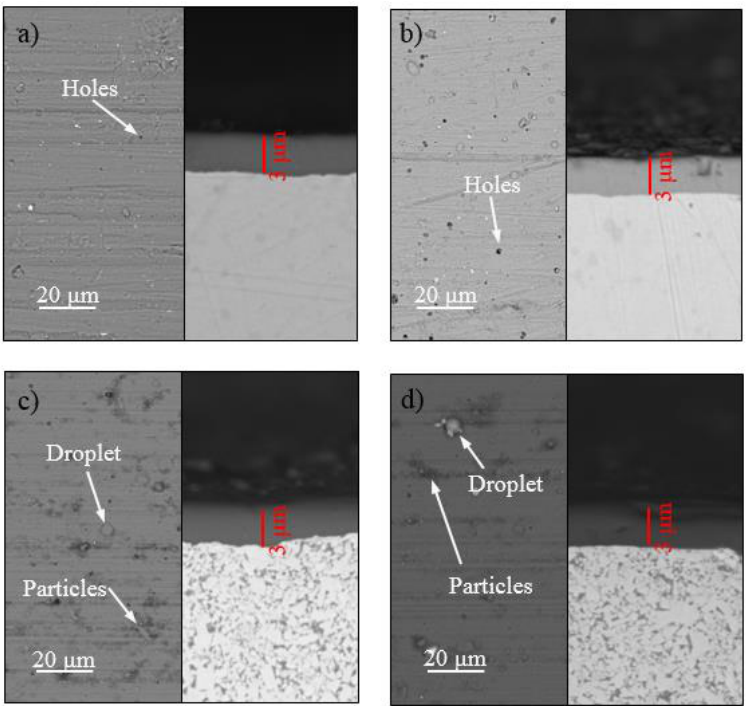
Figure 1. SEM images of the surfaces and cross-sections of coated samples: ( a ) CrN on HSS; ( b ) AlTiN on HSS; ( c ) CrN on WC-Co; ( d ) AlTiN on